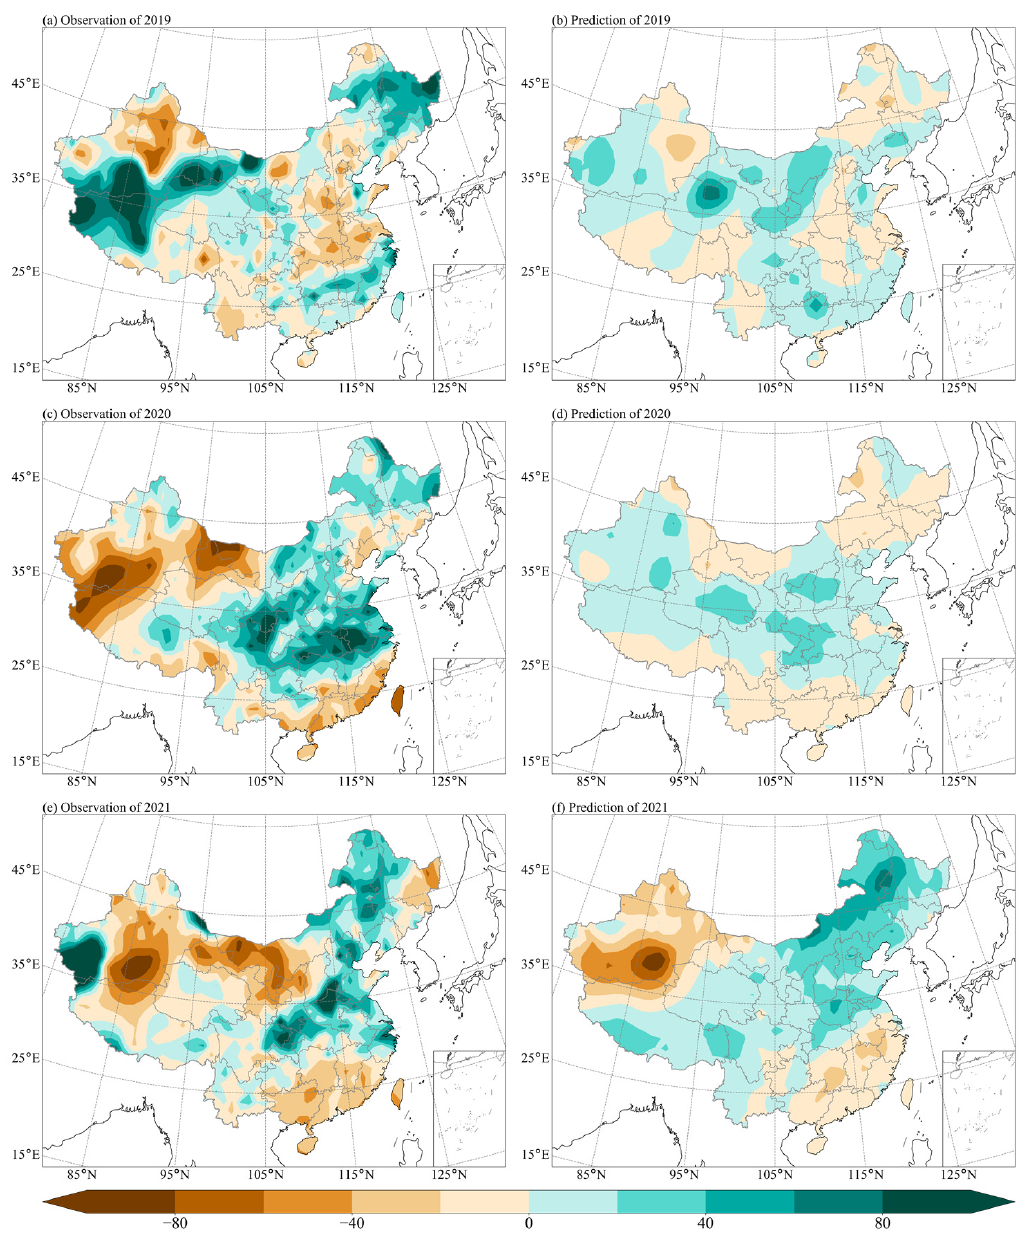
Figure 9. The comparison of summer precipitation anomaly percentage between the MME prediction and observations in China: ( a ) observation of 2019, ( b ) prediction of 2019, ( c ) observation of 2020, ( d ) prediction of 2020, ( e ) observation of 2021, and ( f ) prediction of 2021.